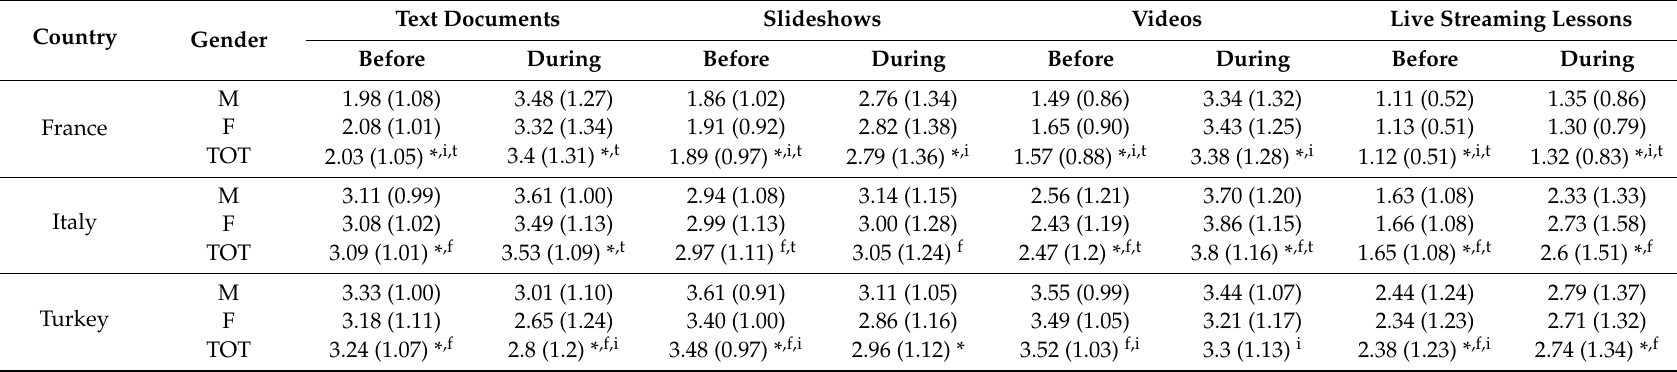
Table 3. Descriptive statistics and Bonferroni Post-hoc pairwise comparisons of the interaction time × country in pedagogical formats supporting PE teachers’ behaviors promoting students’ out-of-school PA.